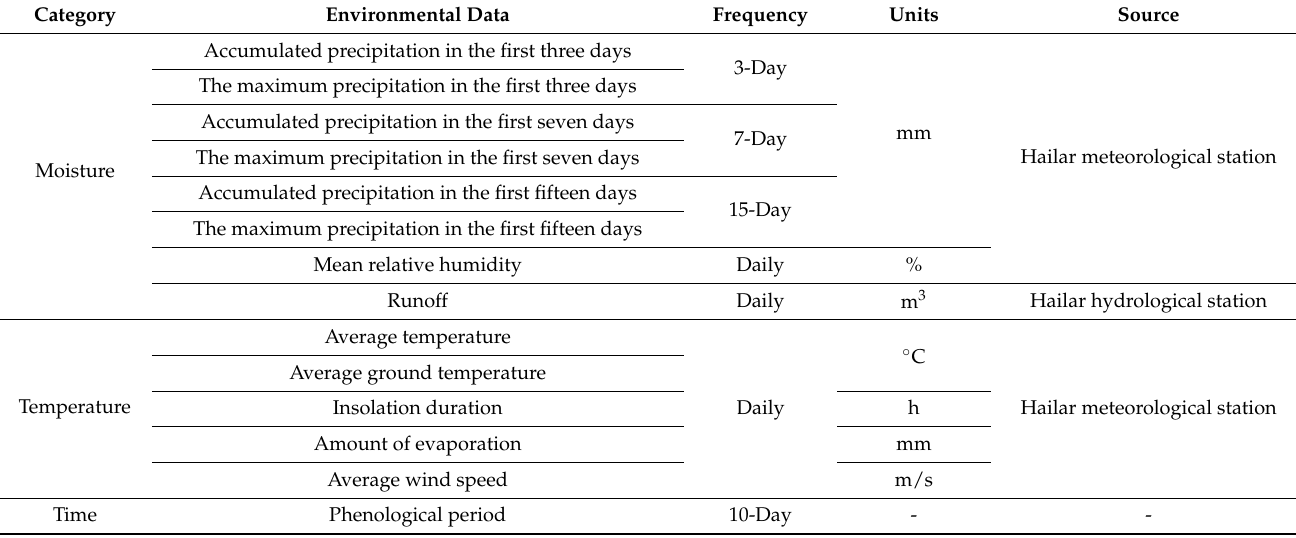
Table 2. Environmental data information.